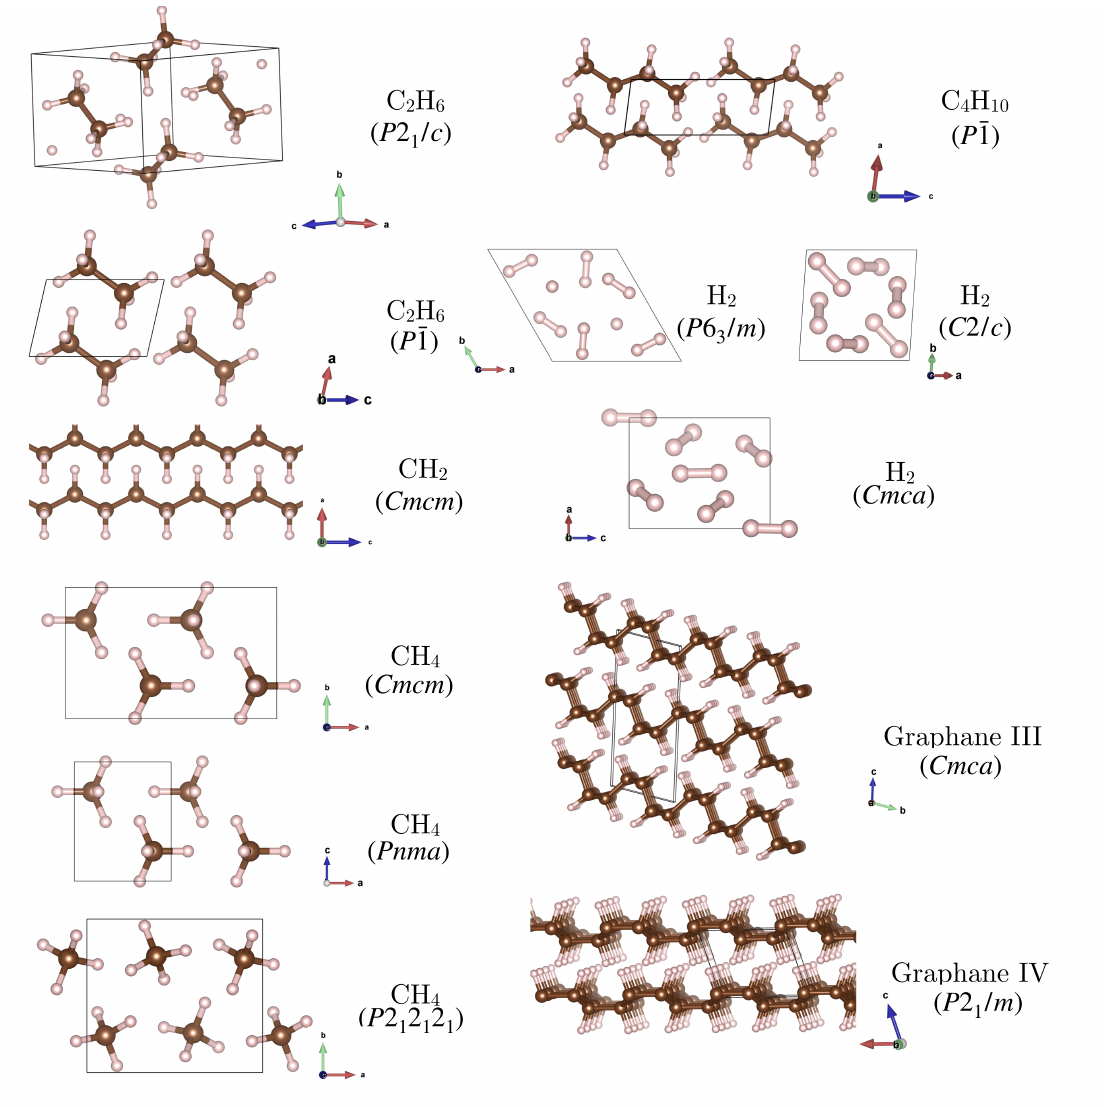
Figure 2. Hydrocarbon structures (other than inclusion compounds) considered in this